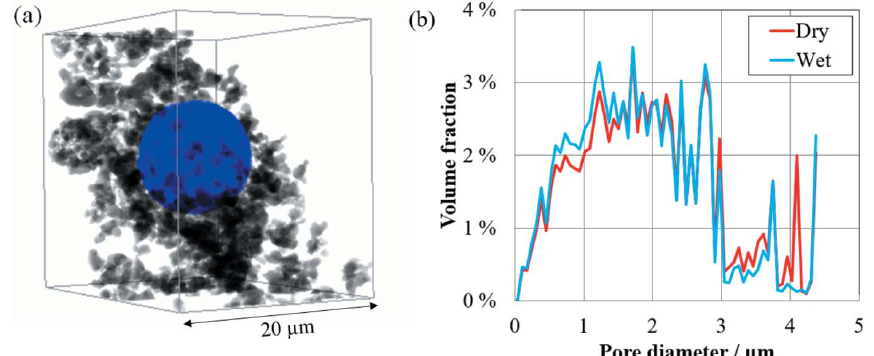
Figure 6 ( a ) 3D volume rendered image cropped around a 8.15 m m water droplet. ( b ) Pore size distribution obtained from the volume rendering image in ( a ) (see Movie S2 of the supporting information). The wet state indicates the distribution with a water droplet, while the dry state indicates that without a water droplet by removal after the binarization process.